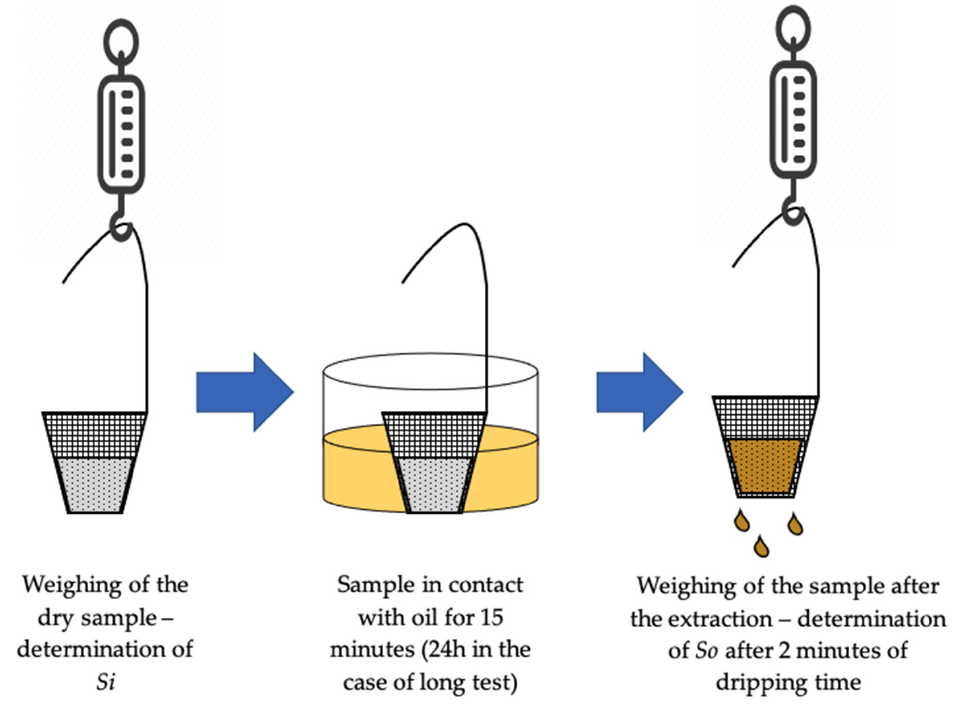
Figure 2. Scheme of the procedure applied for the oil sorption tests.